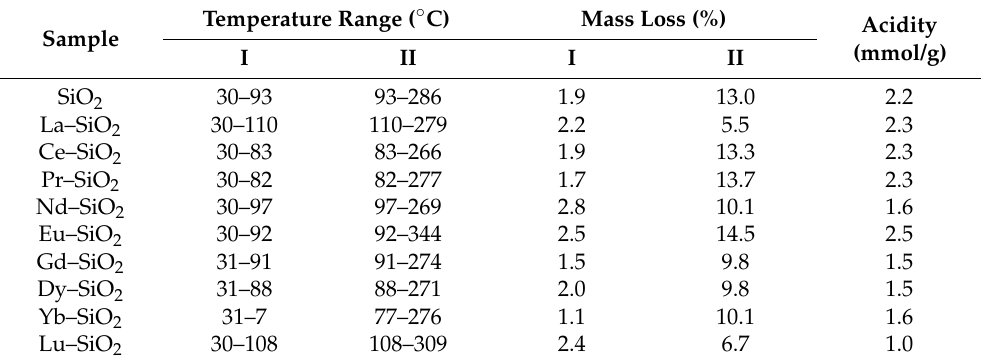
Table 4. Percentage of mass loss for the events associated with n-butylamine desorption from pure SiO 2 and Ln–SiO 2